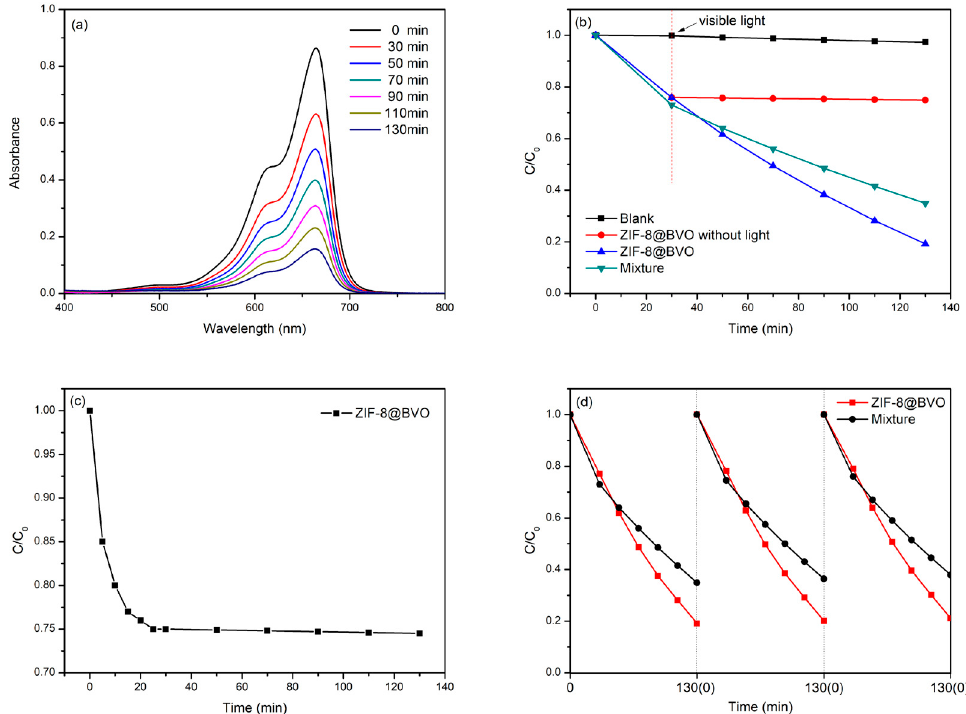
Figure 5 . ( a ) Time-dependent UV–Vis spectrum of methylene blue (MB) solution photodegraded by